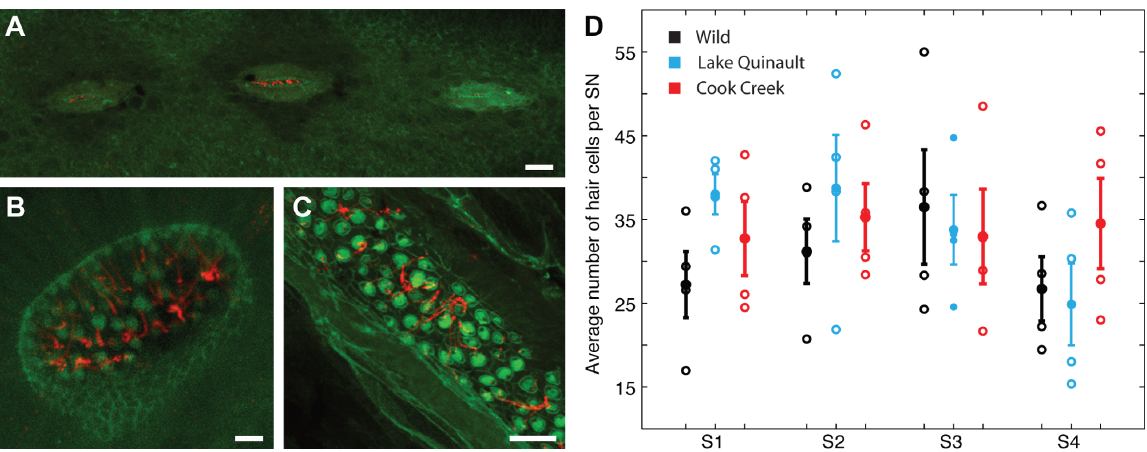
Figure 2. High variability in hair cell number within neuromasts. (A–C) Confocal images (brightest-point projections) of neuromasts double- labeled with anti-acetylated tubulin (red) and phalloidin (green), showing the kinocilia and hair bundles/cuticular plates, respectively. The phalloidin label also delineates overall neuromast architecture. (A) Three neuromasts from stitch S2 of a wild-origin fish, showing neuromast morphology and spacing. (B) Single SN from stitch S3 of a Lake Quinault hatchery fish, demonstrating the rounded morphology sometimes observed. In contrast, elongated SN were more typically noted, illustrated here by the S5 neuromast from a Cook Creek fish (C). (D) Average hair cell number for 4 randomly selected individuals (open circles) from each group for which complete data (SN in all four dissected ROIs S1–S4; range 3–21 SN per ROI) were available, and group means (filled circles, mean 6 1 SEM) for each ROI. There were no significant cross-group differences in hair cell number ( p . 0.05).